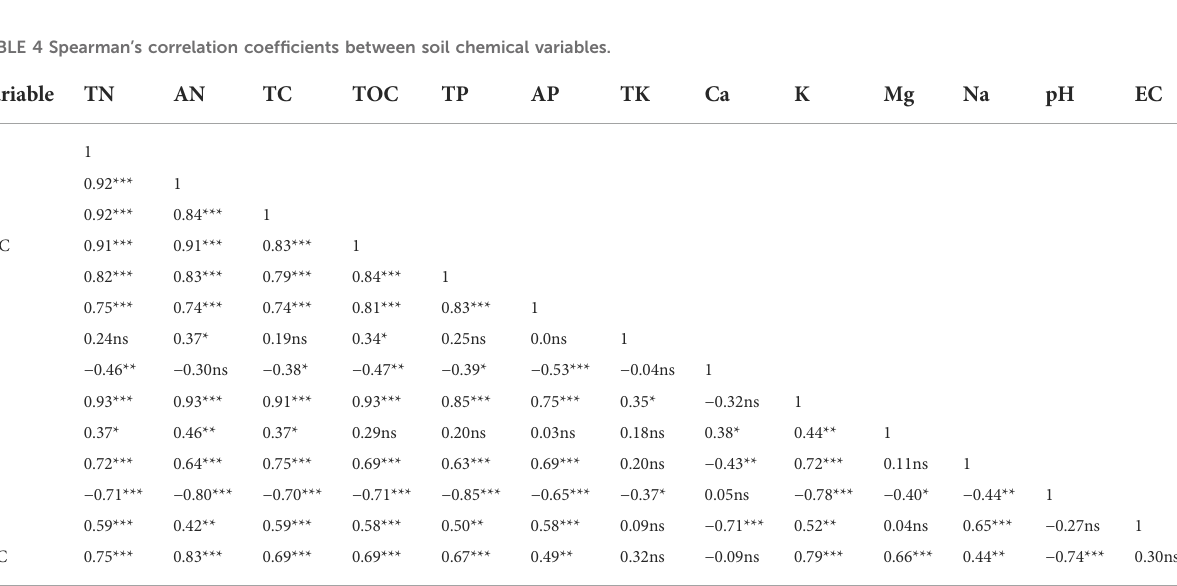
Values are means ± SD. Means followed by the different lower case letters are signi fi cantly different at 5% level by Duncan ’ s multiple range test.